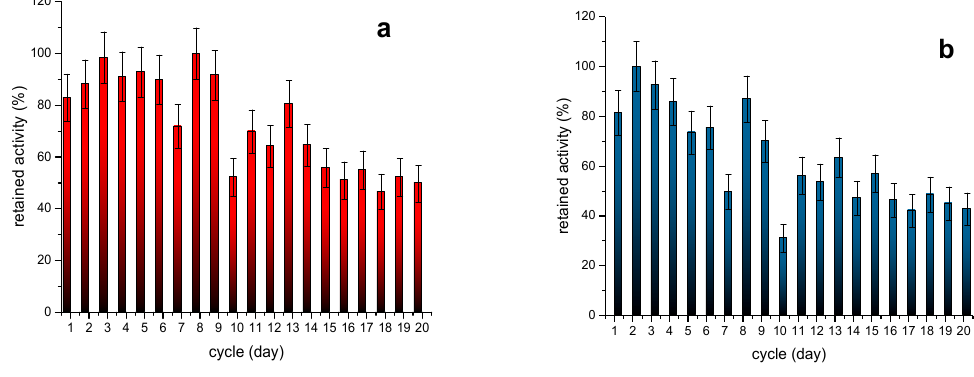
Figure 4. Activity of the composites in ABTS oxidation at 55 °C: HRP ( a ) and LiP ( b ).